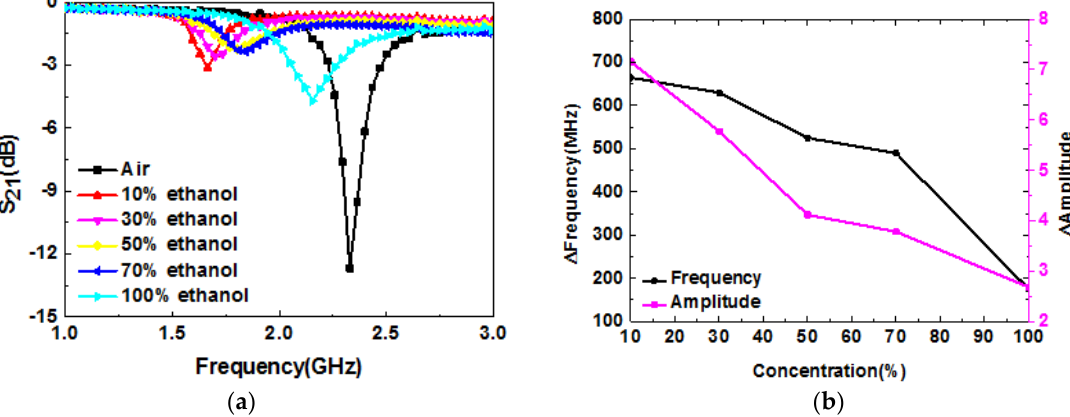
Figure 10. ( a ) Measured resonance characteristics of ethanol – water mixtures at different concentrations; ( b ) Relative variations of frequency and amplitude, compared with the reference.